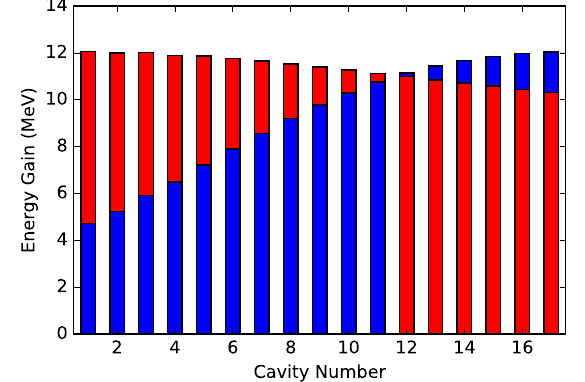
FIG. 2. Energy gain along the LINAC. Blue is the first pass and red is the second pass.